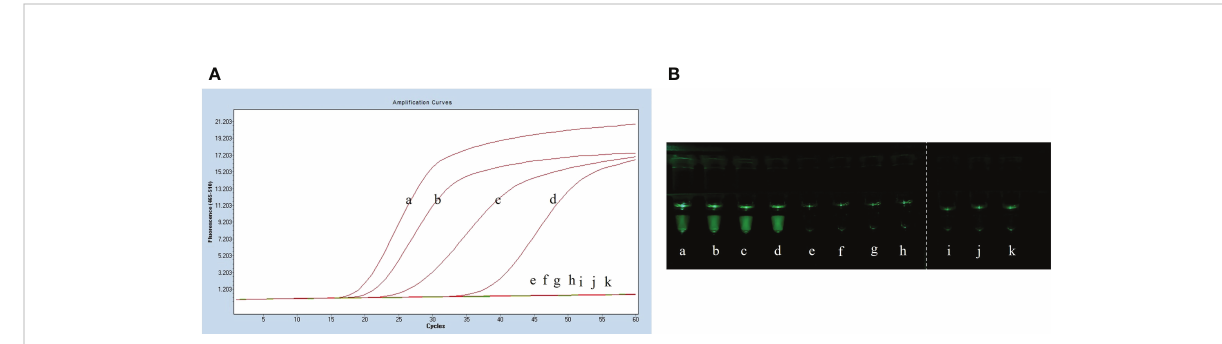
FIGURE 4 Sensitivity test results. (A) Sensitivity test real-time fl uorescence curve results. (B) Visualization of the Sensitivity results using a printed visual function box. In the LP-LAMP method for the detection of genomic DNA, diluted Streptococcus suis serotype 2 genomic DNA was used at the following concentrations: (a) 1.84 × 10 4 CFU, (b) 1.84 × 10 3 CFU, (c) 1.84 × 10 2 CFU, (d) 1.84 × 10 1 CFU, (e) 1.84 × 10 0 CFU, (f) 1.84 × 10 -1 CFU, (g) 1.84 × 10 -2 CFU, (h) 1.84 × 10 -3 CFU, (i), (j) and (k) Negative